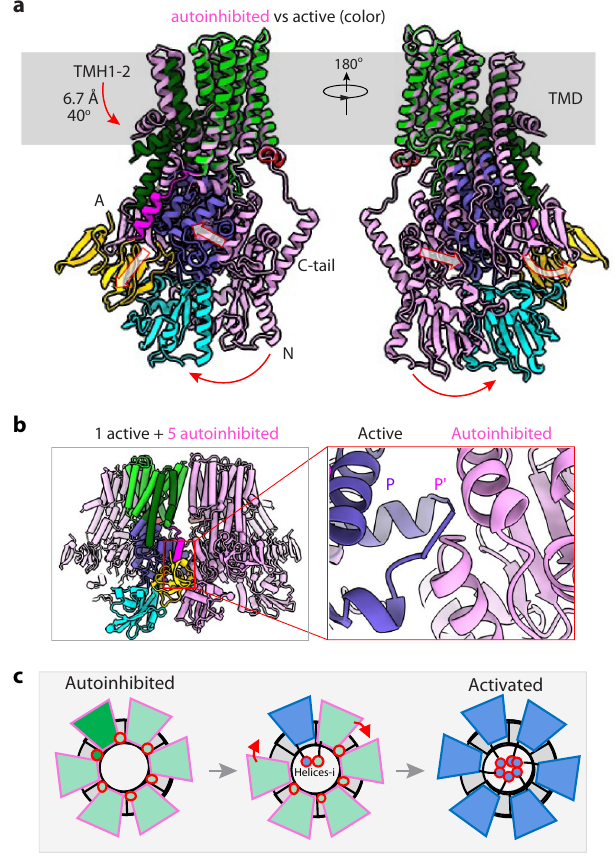
Fig. 4 The cooperative model of the Pma1 hexamer. a Structural comparison of the Pma1 subunit in autoinhibited and activated E2P states. TMH1 – 2 move downward by 6.7 Å and rotate by 40°. b Structural model of the autoinhibited Pma1 hexamer, in which one protomer is replaced by the activated Pma1. The red rectangle highlights the region in which two neighboring P-domains would sterically clash. c A proposed cooperative activation model of the Pma1 hexamer. When one protomer in the Pma1 hexamer is activated, this protomer induces the activation of the next protomer by releasing its helix-i from the neighboring P-domain. Sequential release of the helices-i around the hexamer leads to the activation of all six